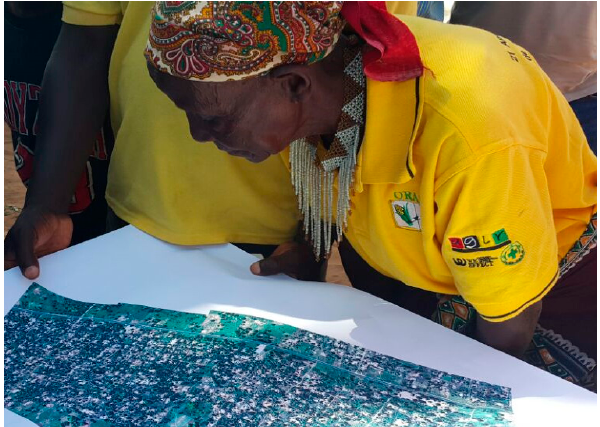
Figure 5. Teaching a “Queen” (female community leader) to read the map.